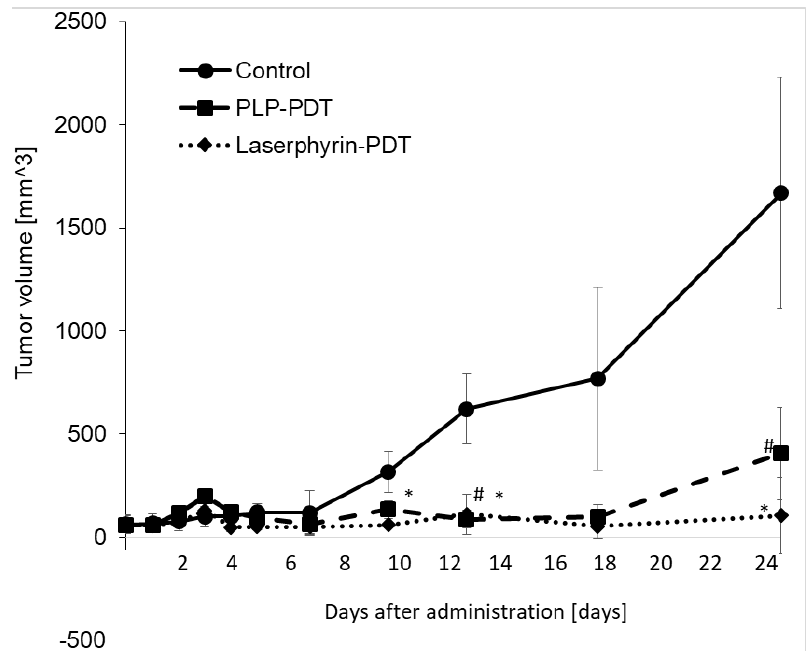
Figure 8. Cytotoxicity effect of PDT using PLP and laserphyrin in vivo. Data are expressed as means ± SD ( n = 3). # p < 0.05 Control vs. PLP PDT. * p < 0.05 Control vs. laserphyrin